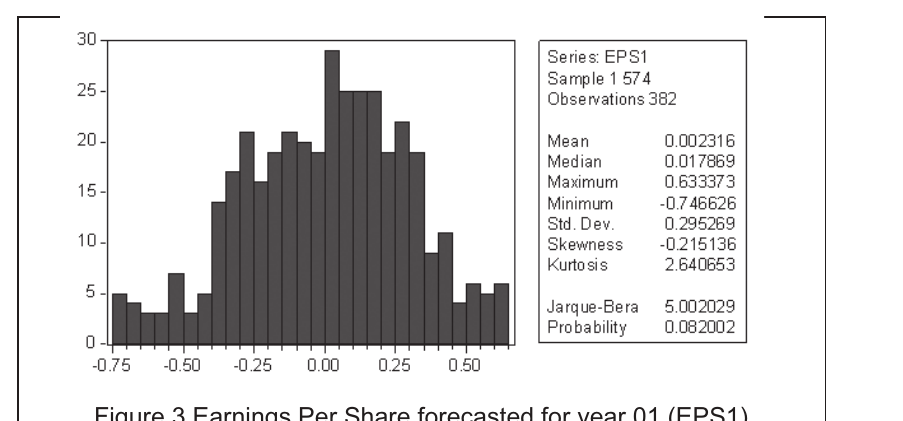
Figure 3 Earnings Per Share forecasted for year 01